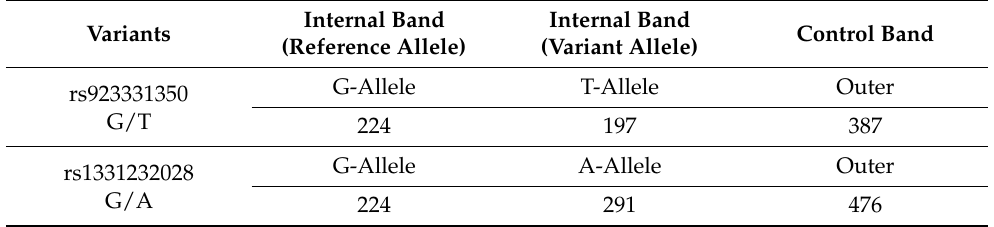
Table 3. Product Size for Genotype